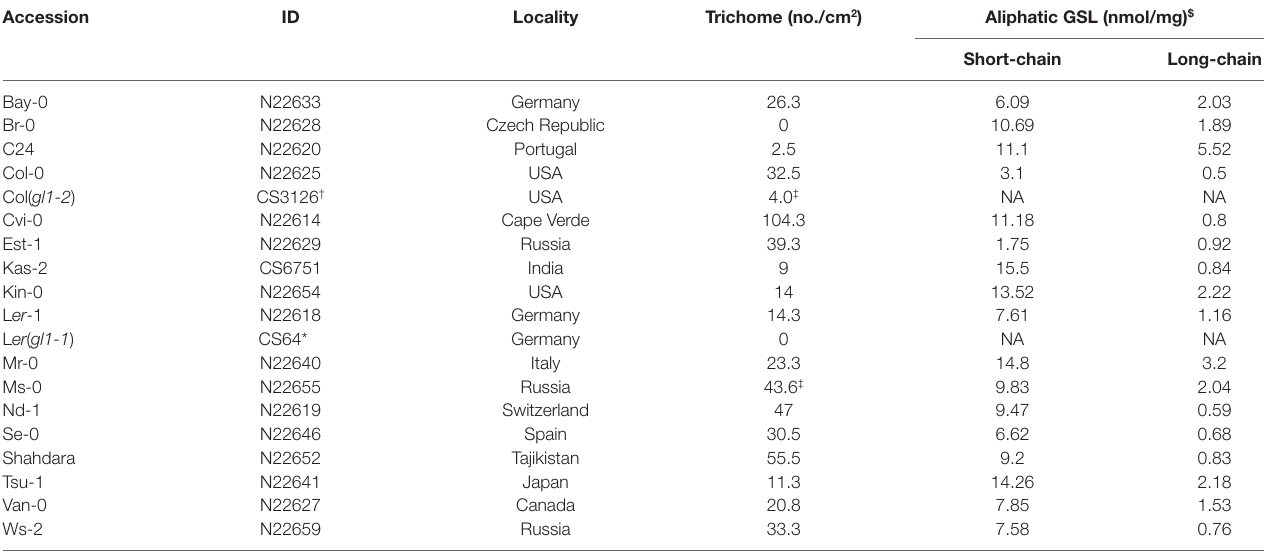
TABLE 1 | List of Arabidopsis thaliana accessions used in this study. Accession ID